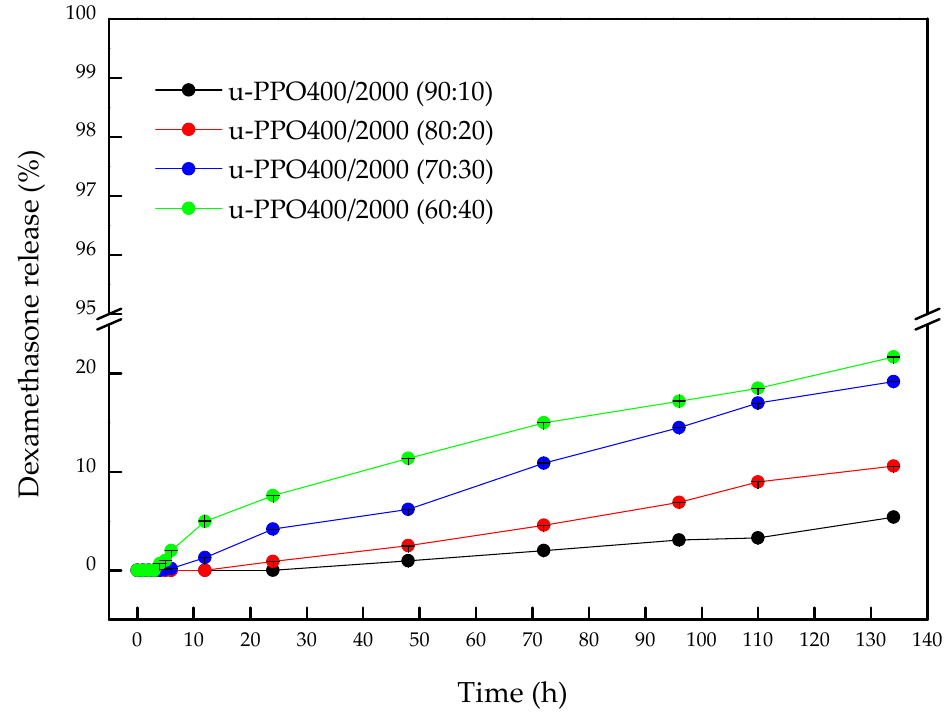
Figure 4. Release profile of dexamethasone incorporated in the u-PPO400/2000 membranes in different proportions: 90:10, 80:20, 70:30, and 60:40. Results are expressed as the mean ± SD of triplicates ( n = 3).